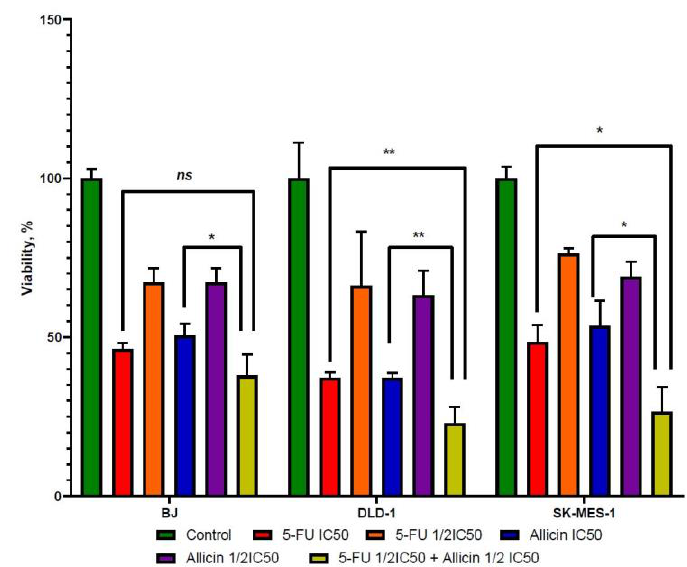
Figure 3. The viability rate analysis of 5-FU combined with allicin compared to each single-agent treatment IC 50 dose. The comparison of the co-treatment and individual compounds indicated that the co-treatment was more effective against tumor cells compared to the cytotoxic drug and allicin alone. Abbreviations: NS, not significant; Control, untreated group; 5-FU IC50, group treated with 5-FU at IC 50 dose; 5-FU 1/2 IC50, group treated with half of 5-FU IC 50 dose; Allicin IC50, group treated with allicin IC 50 dose; Allicin 1/2 IC50, group treated with half of allicin IC 50 dose; 5-FU 1/2 IC50 + Allicin 1/2 IC50, group treated with the combination of 5-FU and allicin half IC 50 doses. The results with p < 0.05 were considered statistically significant (* p < 0.05 and ** p < 0.01).